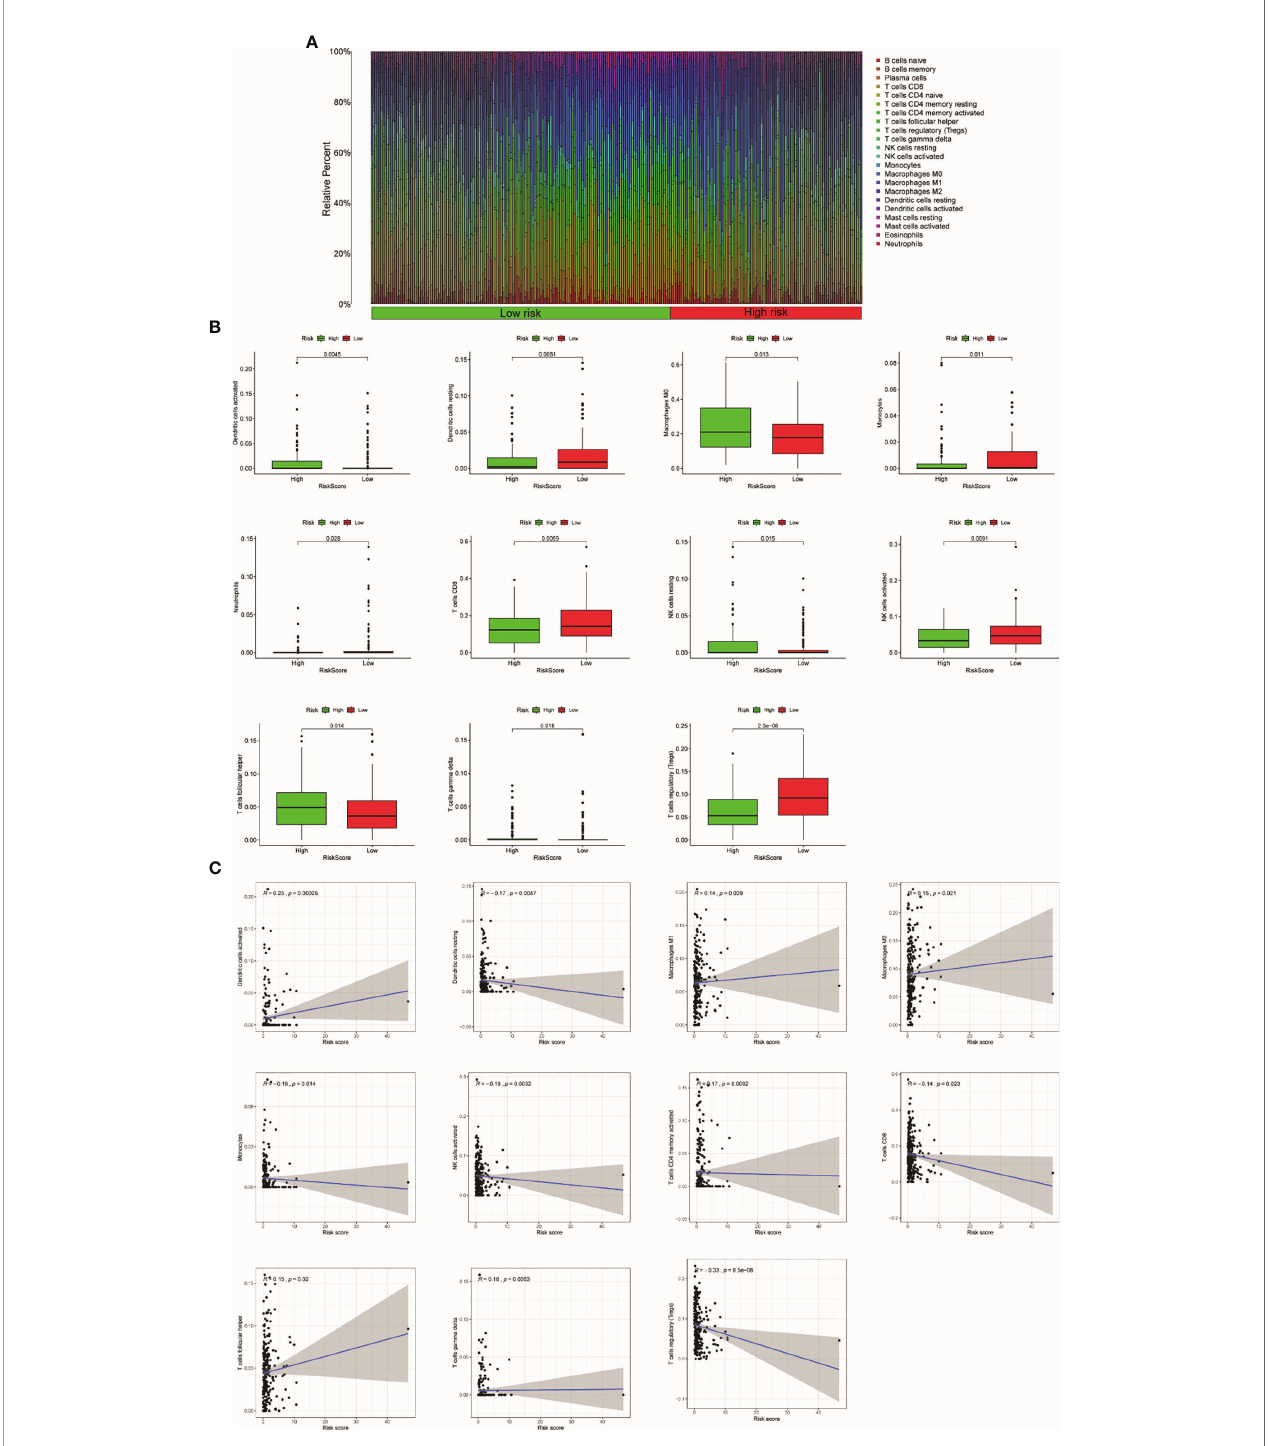
FIGURE 8 | The relationship between the TRRS and immune response. (A) Relative percentage of each type of immune cell in 253 EC samples from TCGA cohort (B) . The difference in immune response between high- and low-risk groups. (C) Relationship between immune response and risk